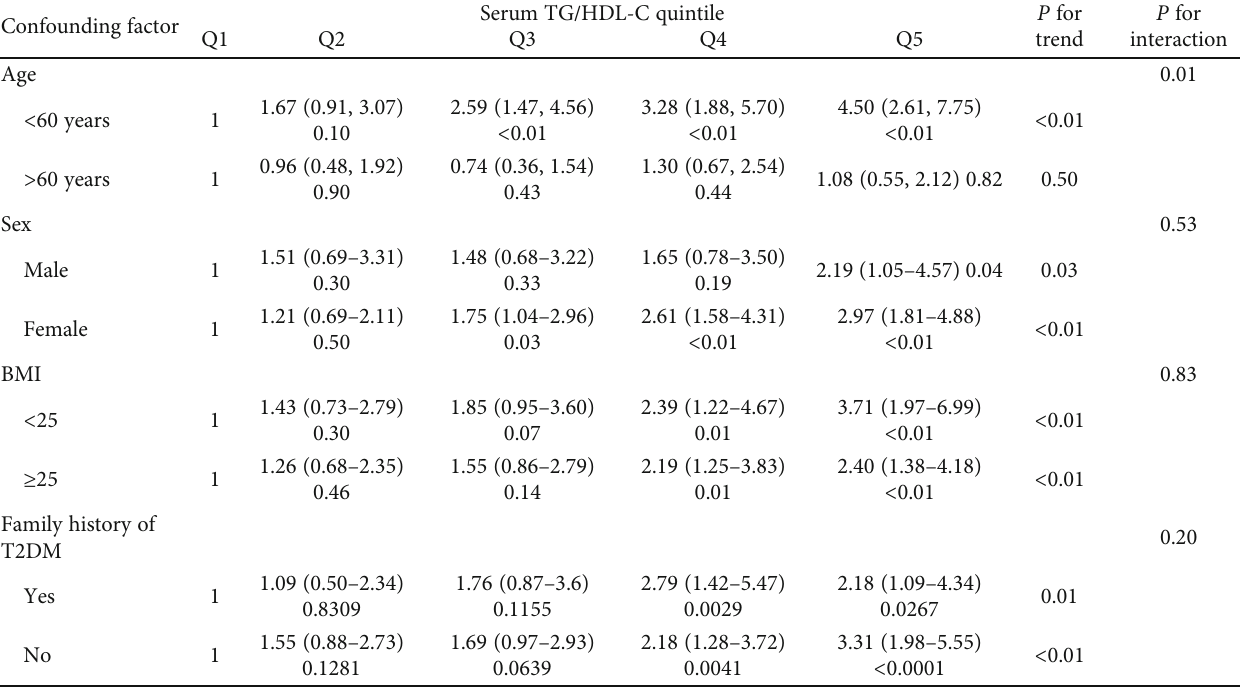
Table 5: Subgroup analyses of the association between TG/HDL-C and incidence of type 2 diabetes mellitus in the REACTION study. Serum TG/HDL-C Confounding factor